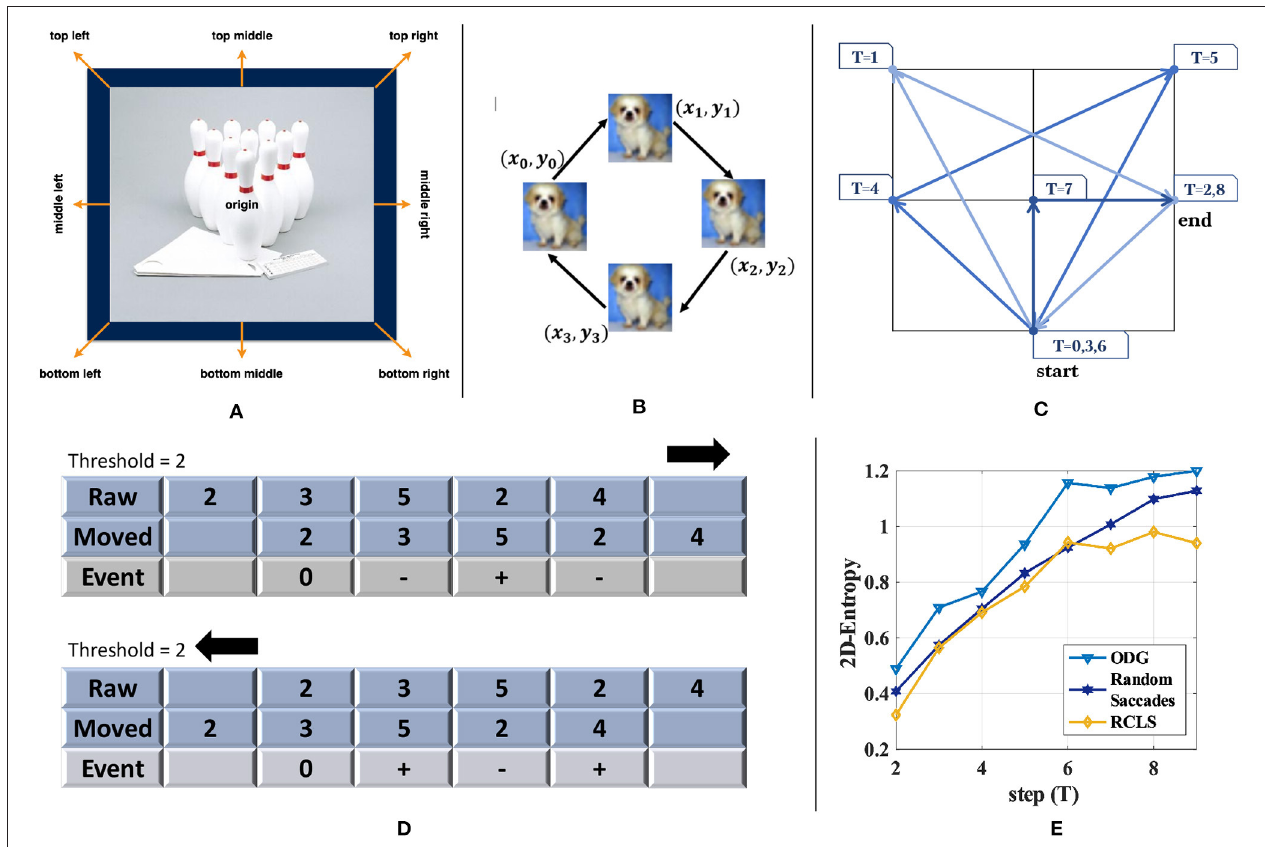
FIGURE 3 | Comparison of three different kinds of image motion. (A) The candidate moving directions used in random saccades generation of DVS-Caltech-256 and DVS-UCF-50 ( Hu et al., 2016). (B) The path used in RCLS of DVS-CIFAR-10 (Li et al., 2017). (C) Trajectory used in ES-ImageNet. (D) Illustration to explain why opposite directions in the generation path would only generate opposite events. (E) 2D-Entropy comparison among the three generating paths with different steps ( T ). ODG is superior to the other two methods in the sense of 2D-Entropy based on the reconstructed gray images.